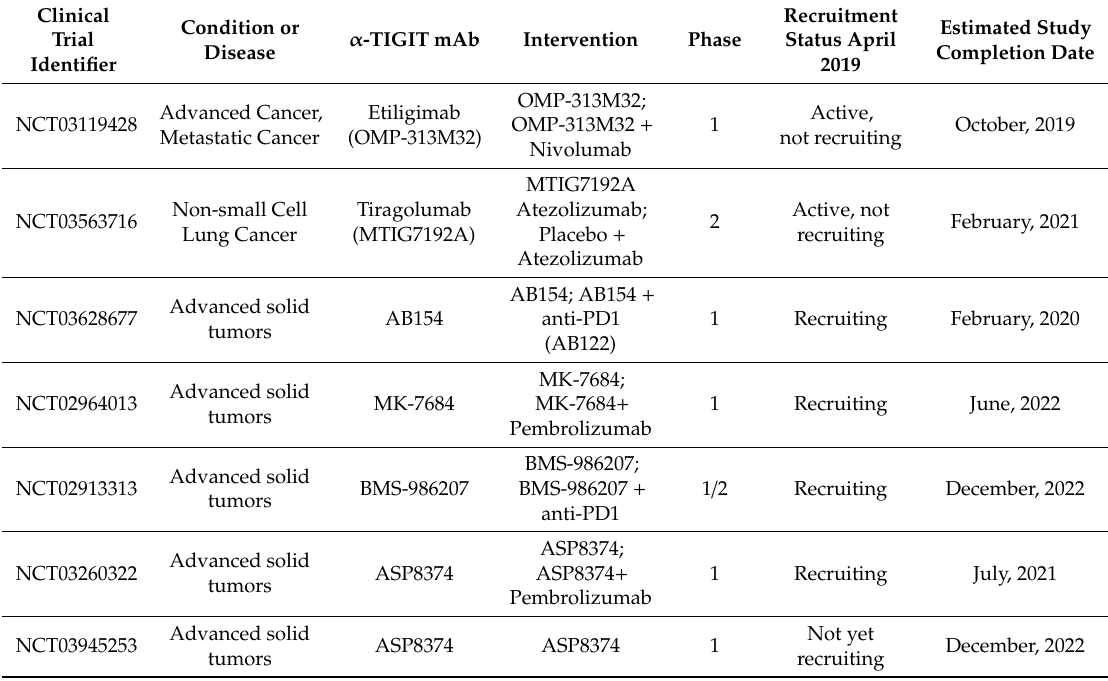
Table 1. Clinical trials based on checkpoint blockade using mAbs against